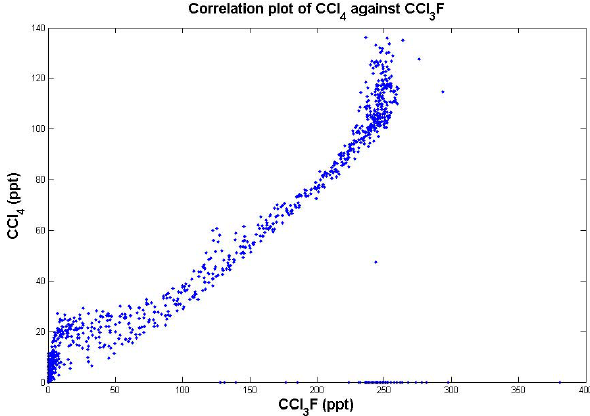
Fig. 10. Correlation plot of CCl 4 VMRs with CCl 3 F VMRs. The lifetime of carbon tetrachloride was estimated to be 34 ± 5 years from the linear part of the correlation with